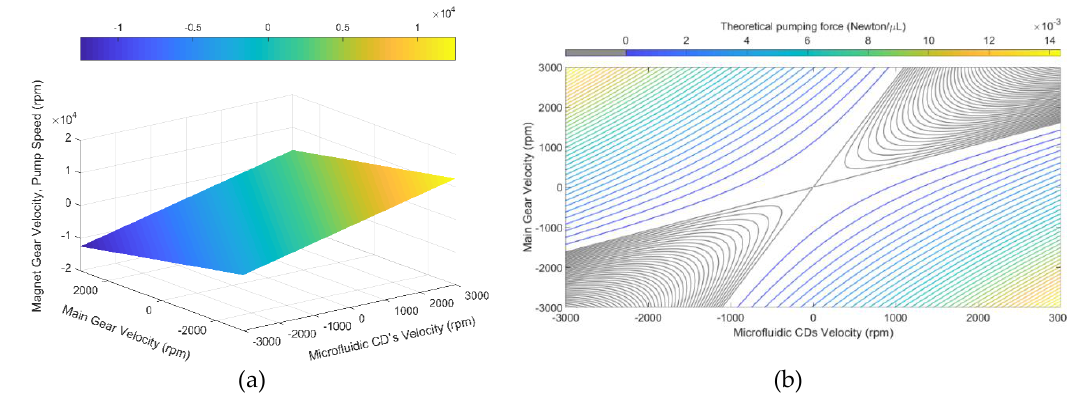
Figure 2. ( a ) Theoretical 3D modeling of the magnet-gear angular velocity (pump speed) with varying both speeds and directions of the main gear and the microfluidic CD; and ( b ) theoretical (ideal) pumping force by the pump as function of the velocities of main gear and microfluidic